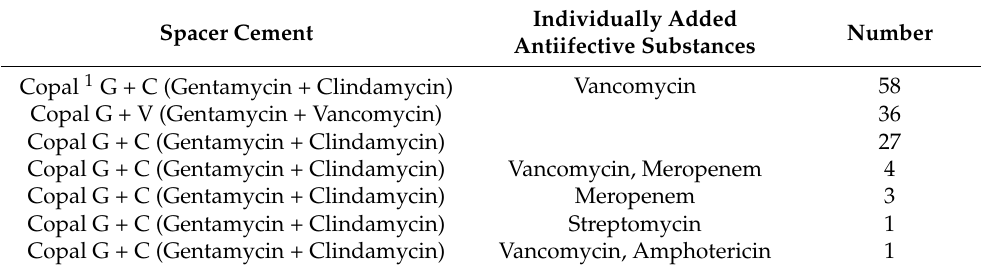
Table 2. Spacer cement and the individual mixture of added anti-infective substances. Spacer